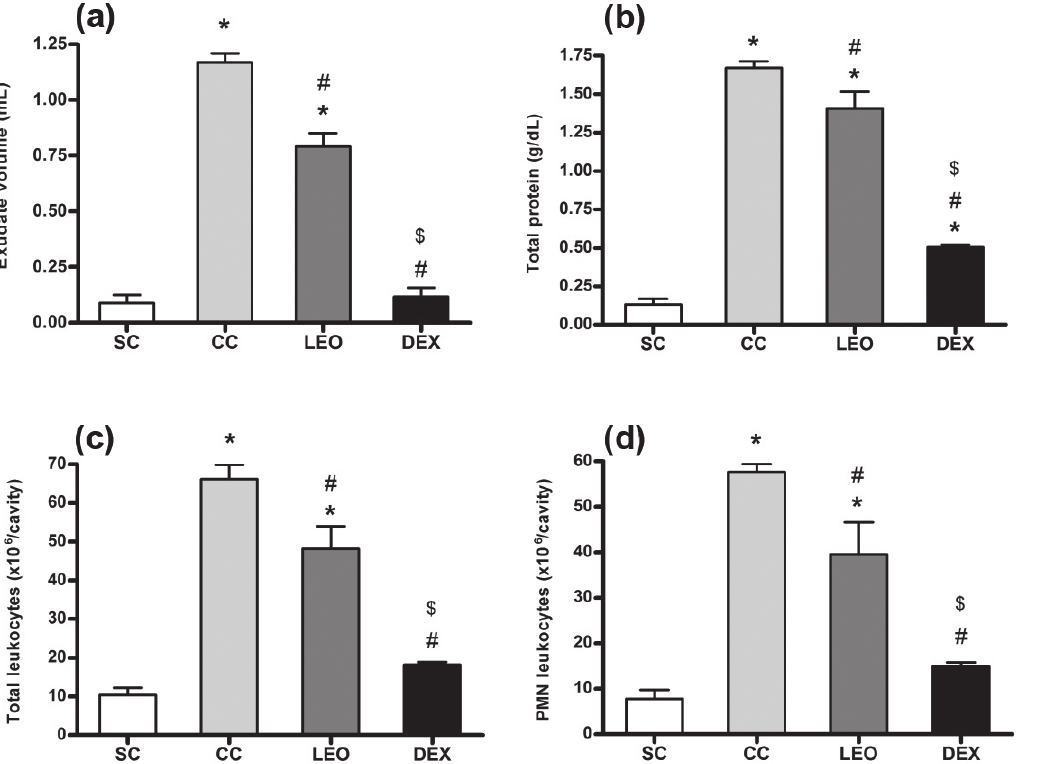
Figure 2 - Effect of pre-treatment with the lavender essential oil (LEO, 0.6 g/kg, p.o.) and dexamethasone (DEX, 0.5 mg/kg s.c.) on pleurisy induced by carrageenan (2 mg/cavity) on exudation ( a ), total protein concentration on exudates ( b ), number of total leukocytes ( c ) and PMN leukocytes ( d ). Values represent the mean ± SEM. * p < 0.05 vs. saline control group (SC); # p < 0.05 vs. carrageenan control group (CC); $ p < 0.05 vs LEO